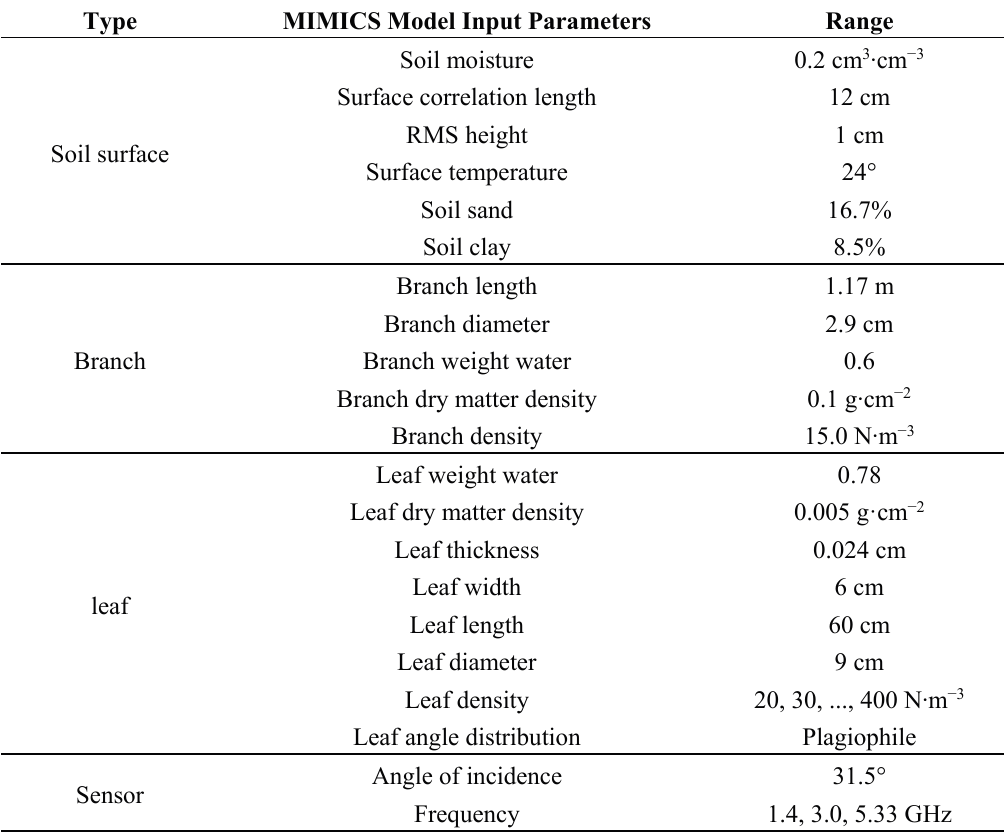
Table 1. Input Parameters of michigan microwave canopy scattering